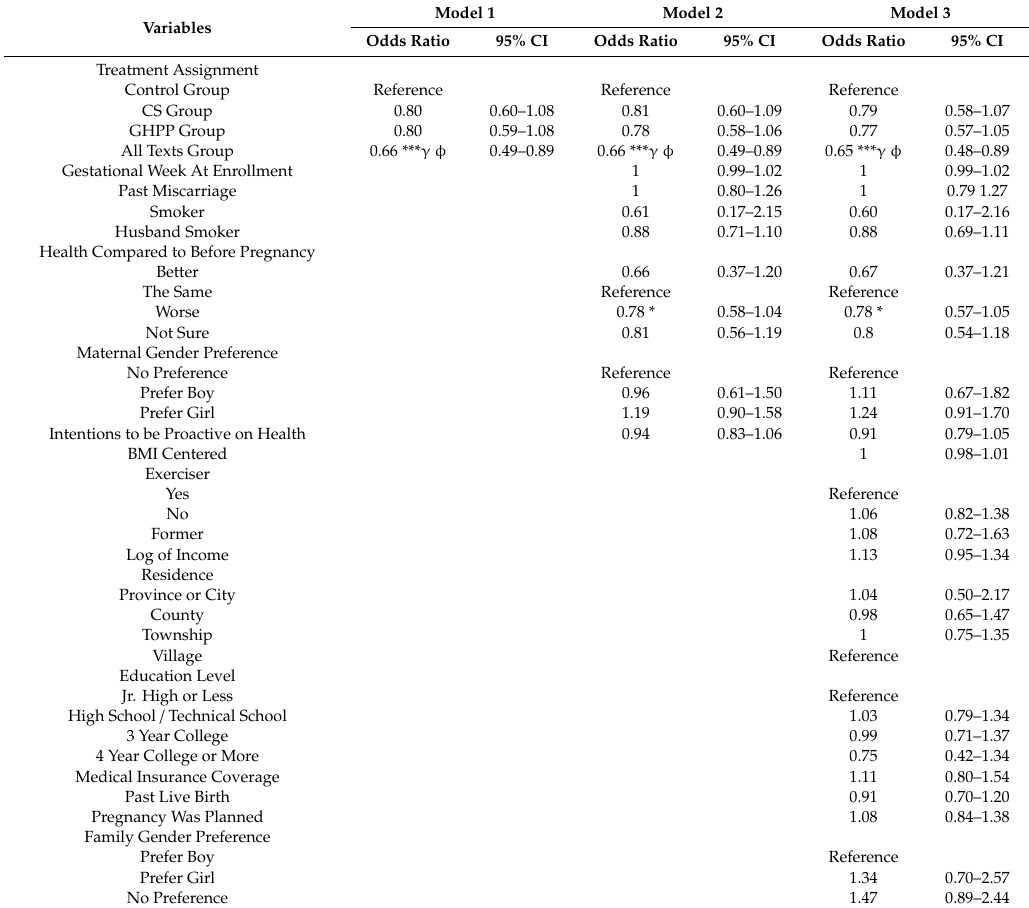
Table 3. Logistic Regression models with inappropriate weight for gestational age (IWGA) as the dependent